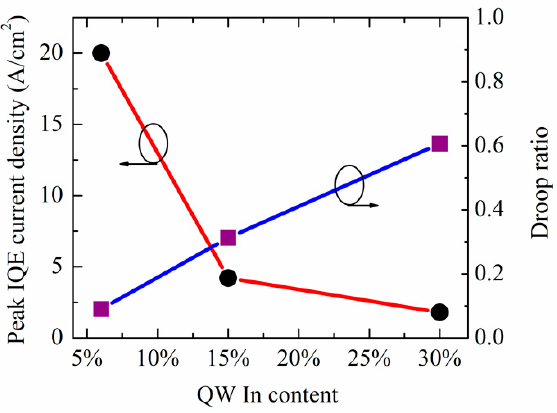
Figure 2. QW In composition-dependent onset-droop current density and droop ratio at 100 A/cm 2 . Droop ratio is defined as (Max_IQE-IQE)/Max_IQE, where Max_IQE represents peak IQE. The